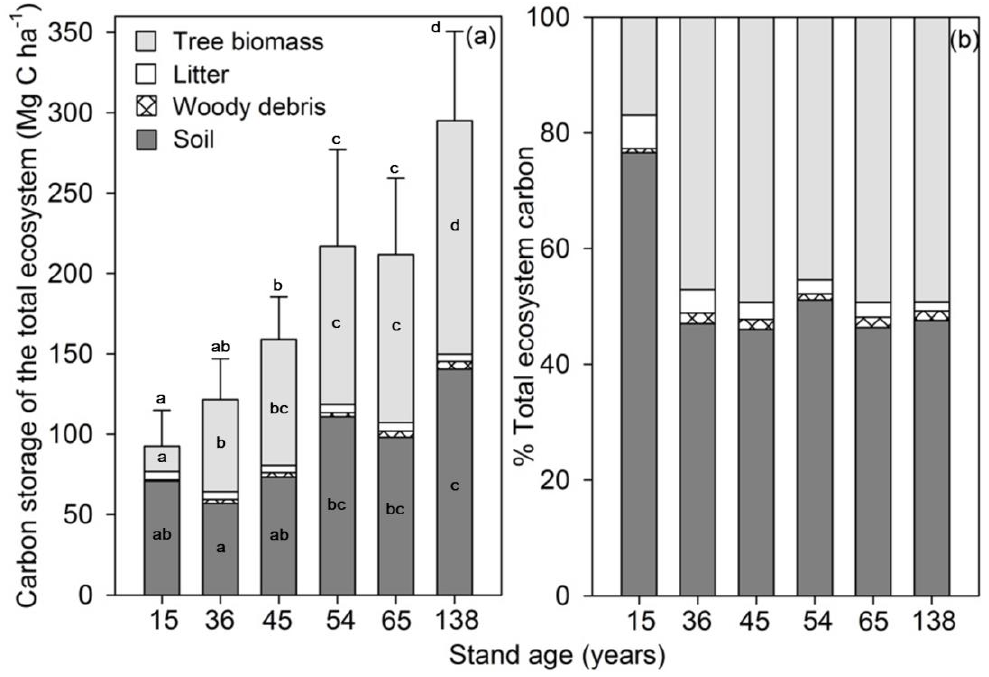
Figure 2. Absolute ( a ) and relative ( b ) distribution within ecosystem carbon components for the six Larix gmelinii stands.